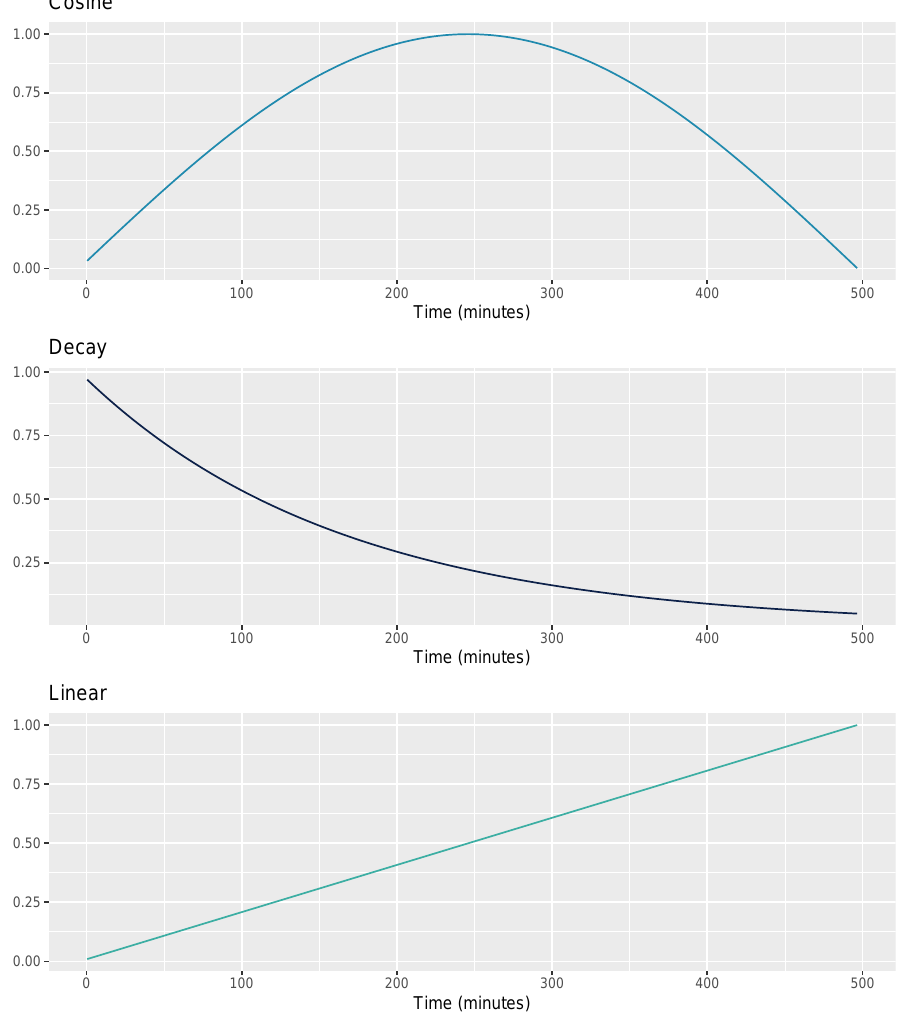
Figure 4. Cosine, decay, and linear functions used to model sensor-independent circadian